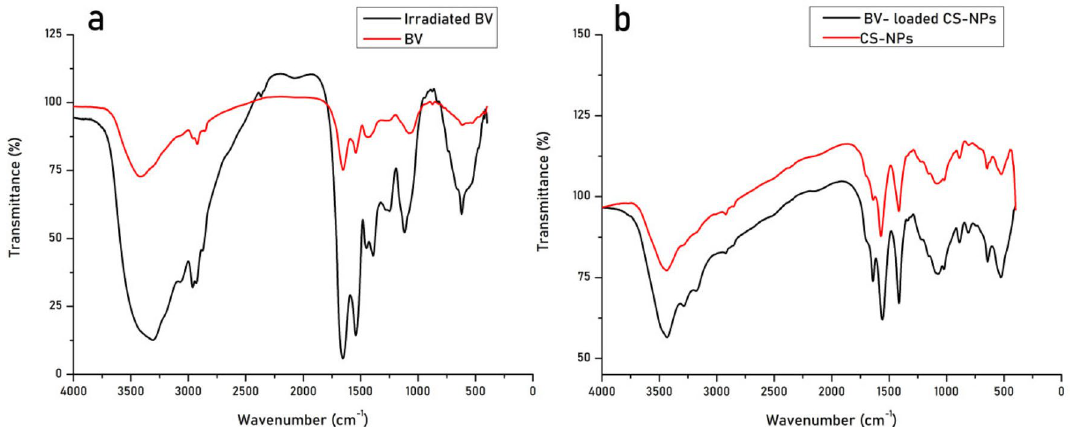
Figure 1. FTIR spectra of ( a ) 20 kGy gamma-irradiated BV compared to BV and ( b ) CS-NPs compared to BV-loaded CS-NPs. -BV: Bee venom, CS-NPs: Chitosan nanoparticles, BV-loaded CS-NPs: Bee venom-loaded Chitosan